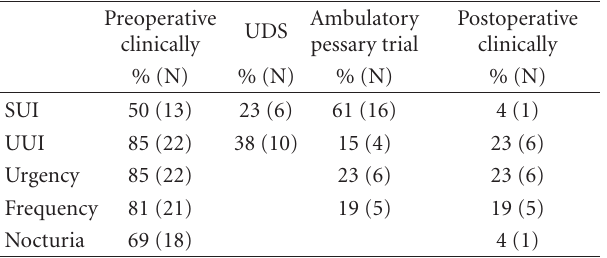
Table 1: Patients demonstrating SUI, UUI, urgency, frequency, and tively.